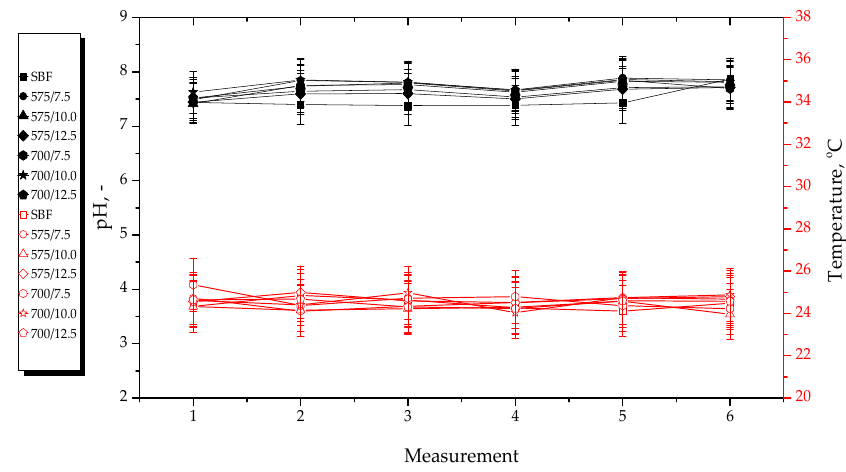
Figure 11. pH and temperature measurements during incubation of hydrogels in distilled water.